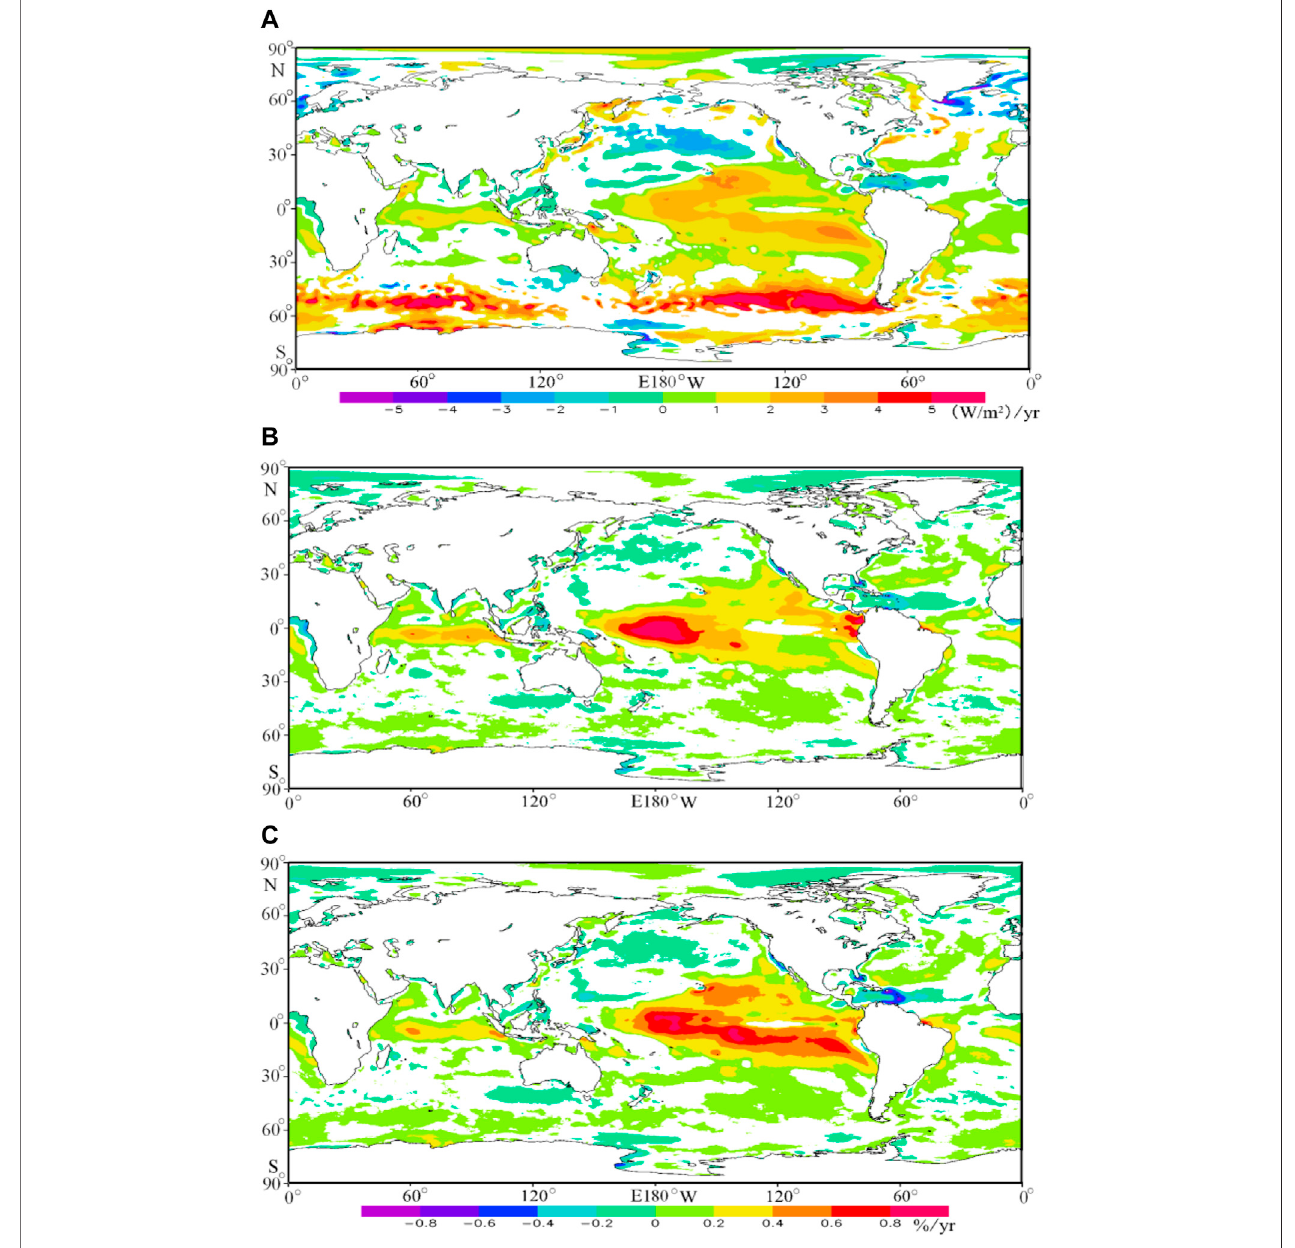
FIGURE 5 | Annual climatic trends of the wind power density (A) , effective wind speed occurrence (B) , and rich level occurrence (C) in the globalocean. Only area signi fi cant at 95% level is presented.